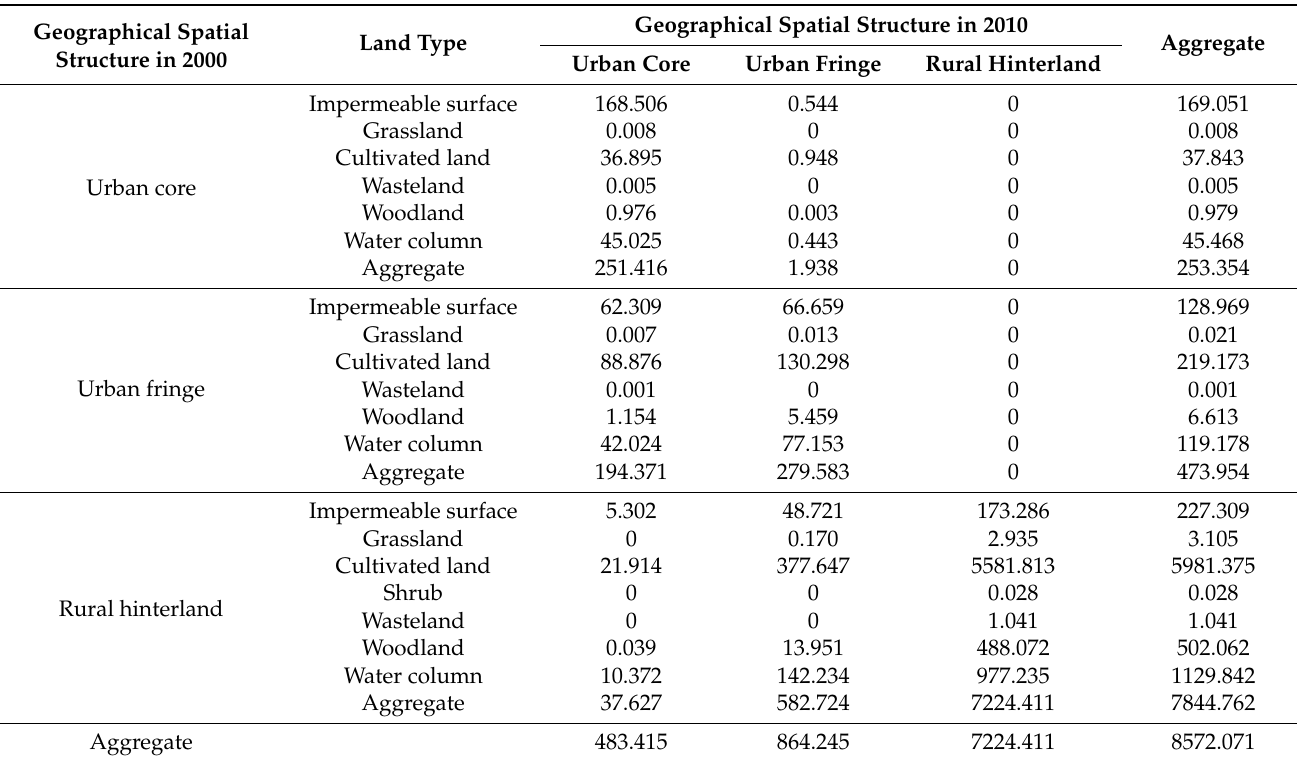
Table 12. Urban geographical structure land-use transfer in Wuhan City, 2000–2010.